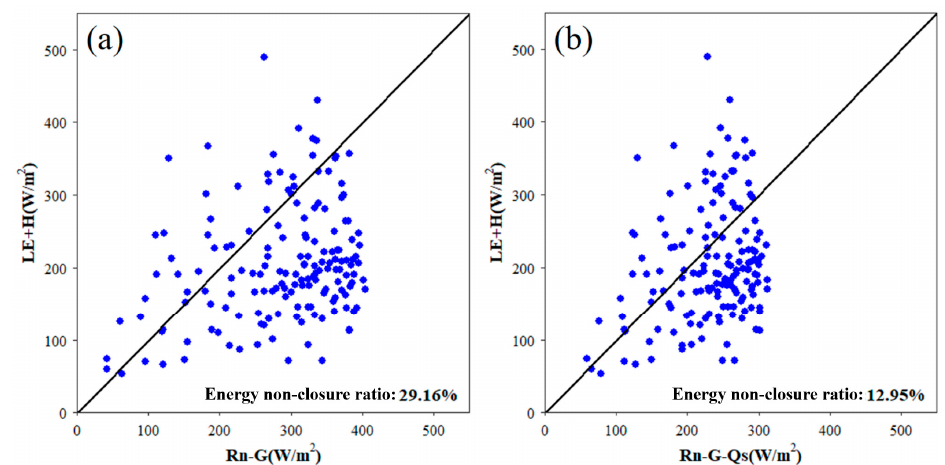
Figure 7. The sums of the observed latent and sensible heat by the EC system are compared with the net energy input (( a ) ignoring the urban canopy storage; ( b ) considering the urban canopy storage heat).